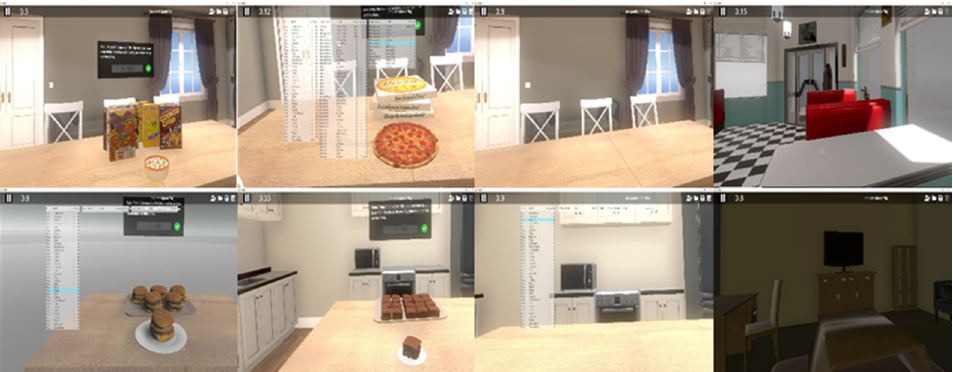
Figure 2. Virtual environments and foods.